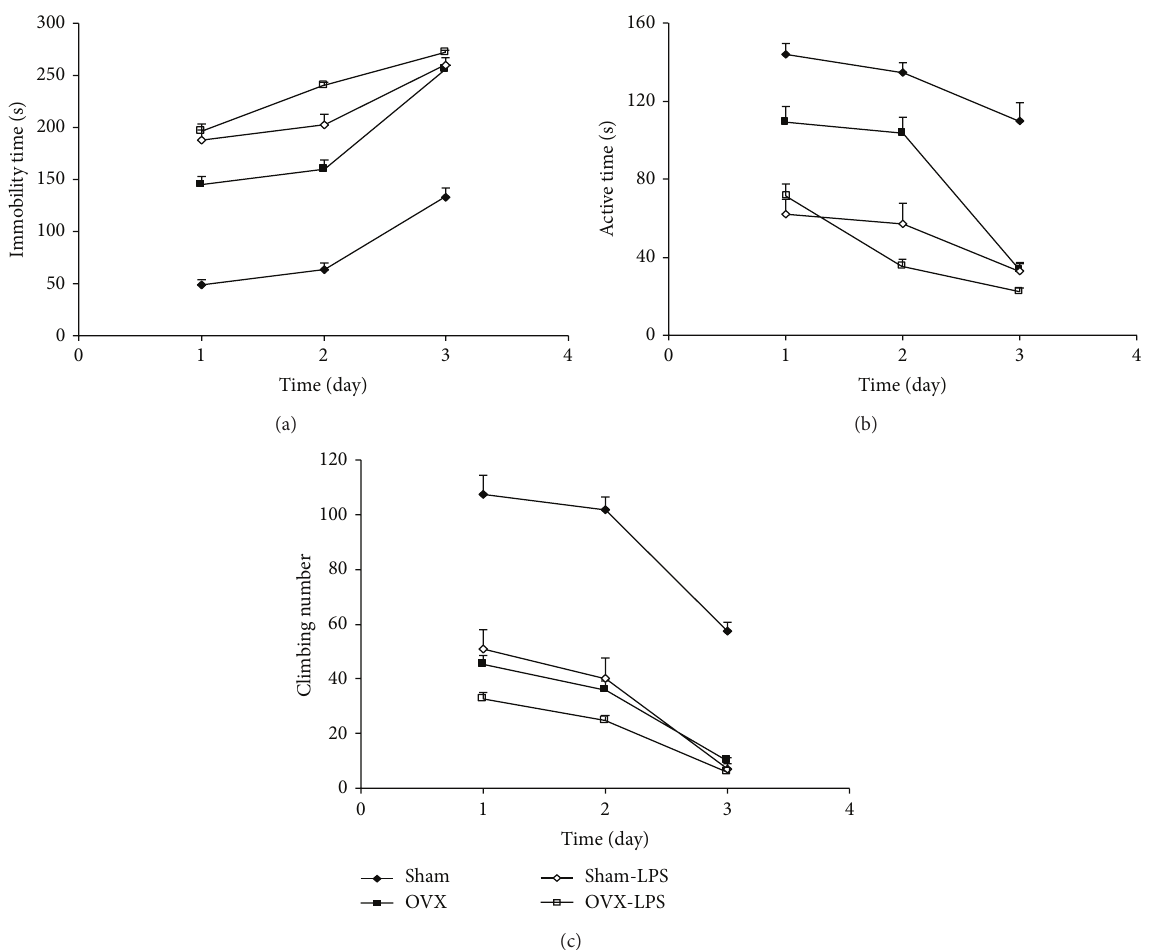
Figure 1: Comparison of immobility times (a), active times (b), and the number of climbing (c) in the forced swimming test between four groups. Data are expressed as mean ± SEM ( 𝑛 = 10 in each group). The repeated measures ANOVA showed that the immobility times in the OVX group were higher while, the active times were lower than those of the Sham group ( 𝑃 < 0.001 ). The immobility times in the Sham-LPS group were higher while, the active times than those of the Sham group ( 𝑃 < 0.001 ). In OVX-LPS group, the immobility times were higher while the active times were lower than those of the OVX group ( 𝑃 < 0.001 ). The climbing number in both Sham-LPS and OVX groups were lower than that of the Sham group ( 𝑃 < 0.001 ). There were no significant differences between OVX-LPS and OVX